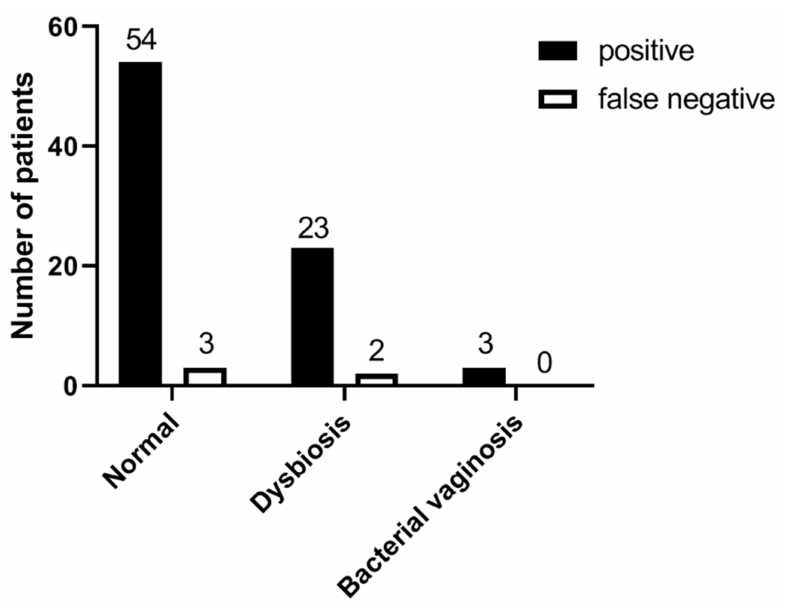
Figure 3. Results of the SavvyCheck ™ Vaginal Yeast Test and vaginal microbiota in 85 study participants of the study